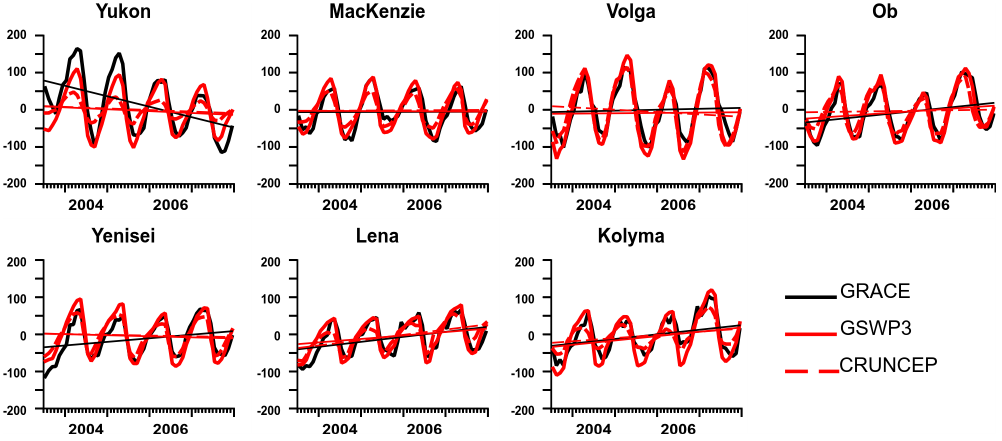
Figure 8. Interannual monthly variation and trend (line) of TWS (mm) simulated with the two forcings compared to GRACE data over the seven basins (see Fig. 2b), for the period July 2003–December